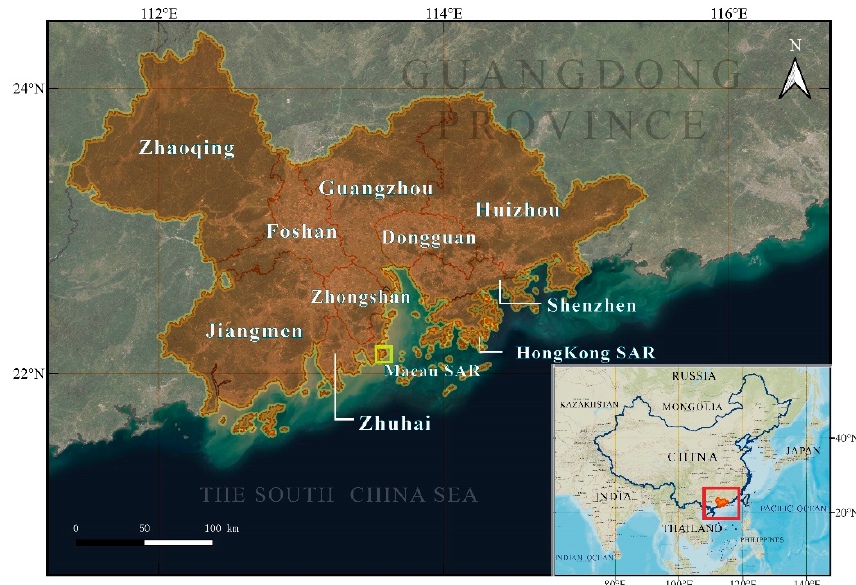
Figure 1. Administrative divisions of the Guangdong–Hong Kong–Macao Greater Bay Area